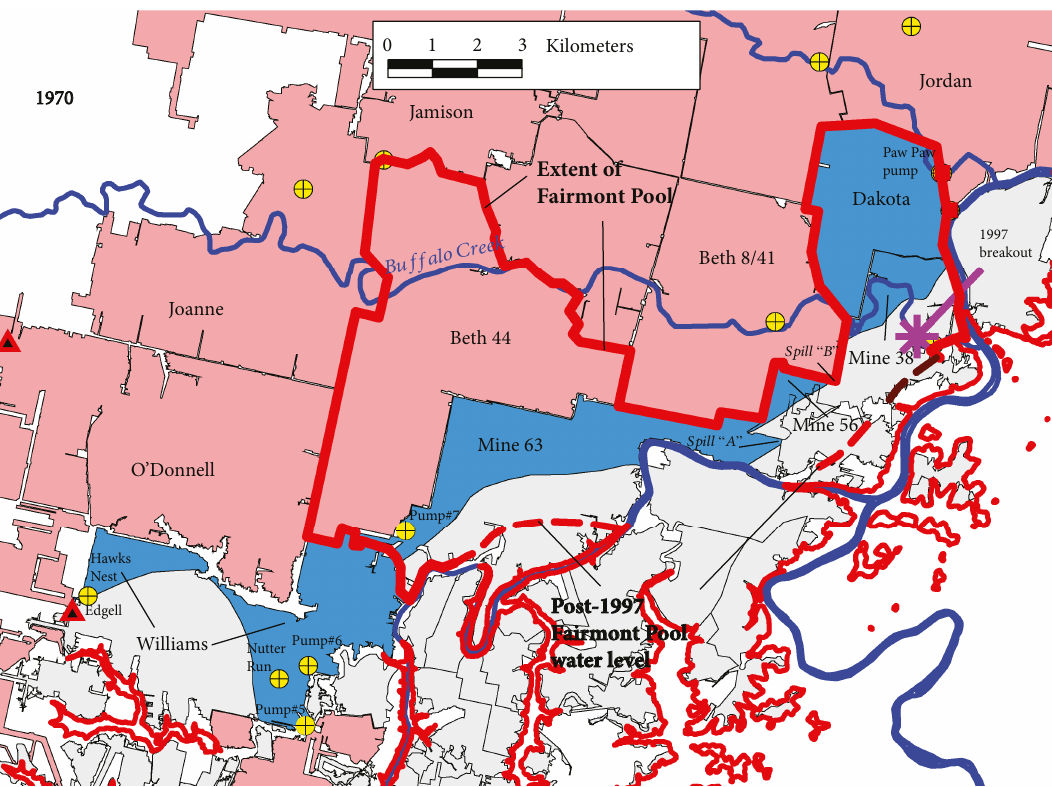
Figure 10: Closer view of phase 1 fl ooding progress in year 1970 showing Williams Pool and the three subpools (mines 63, 56, and 38) that later merged into the Fairmont Pool. Ultimate extent of the fl ooded Fairmont Pool is shown in thick red line, dashed along the “ beach ” location. Purple symbol represents location of Bu ff alo Creek mine water breakout in